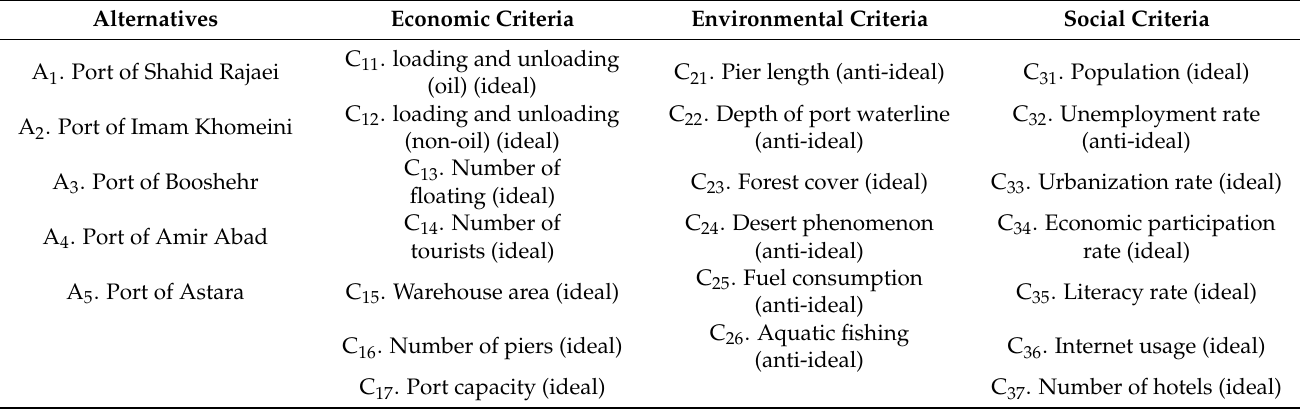
Table 4. Decision matrix for economic